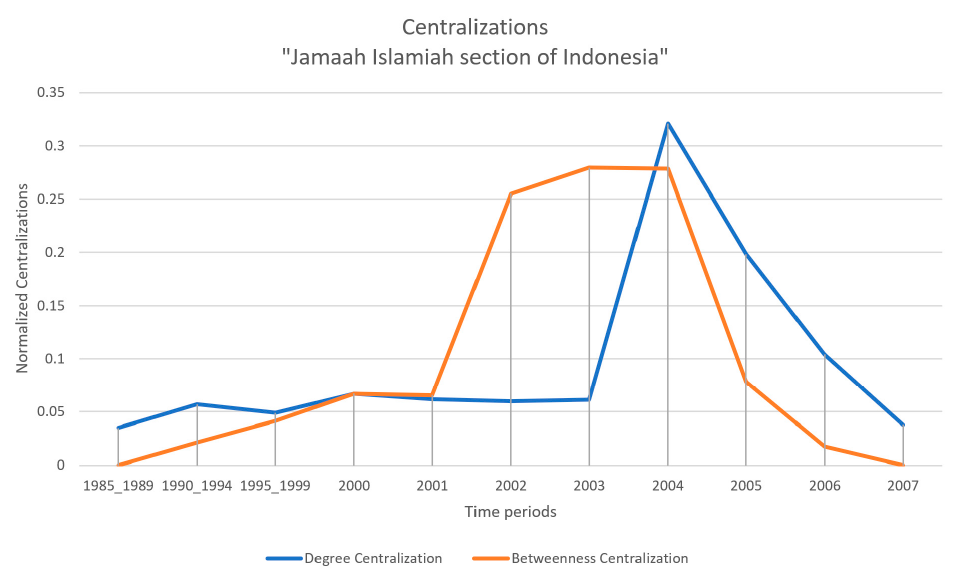
Figure 9. Temporal development of degree and betweenness centralizations for the “Jamaah Islamiah section of Indonesia”. Both indices increase, reaching a maximum in 2004, and then decrease. Degree centralization increases rapidly after 2003, and then decreases. Betweenness centralization increases rapidly two years earlier, i.e., after 2001, and then decreases rapidly.